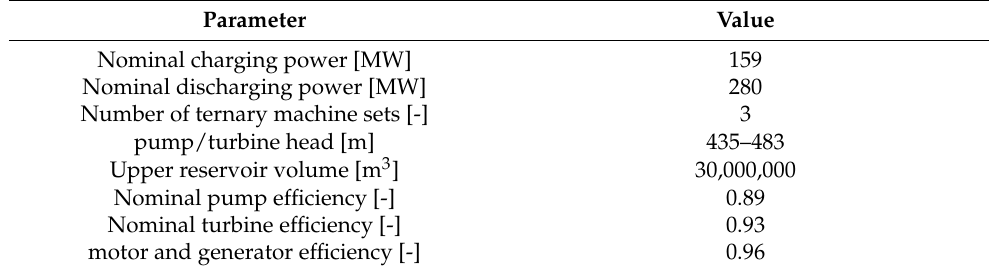
Table 2. Design parameters of the PHES.